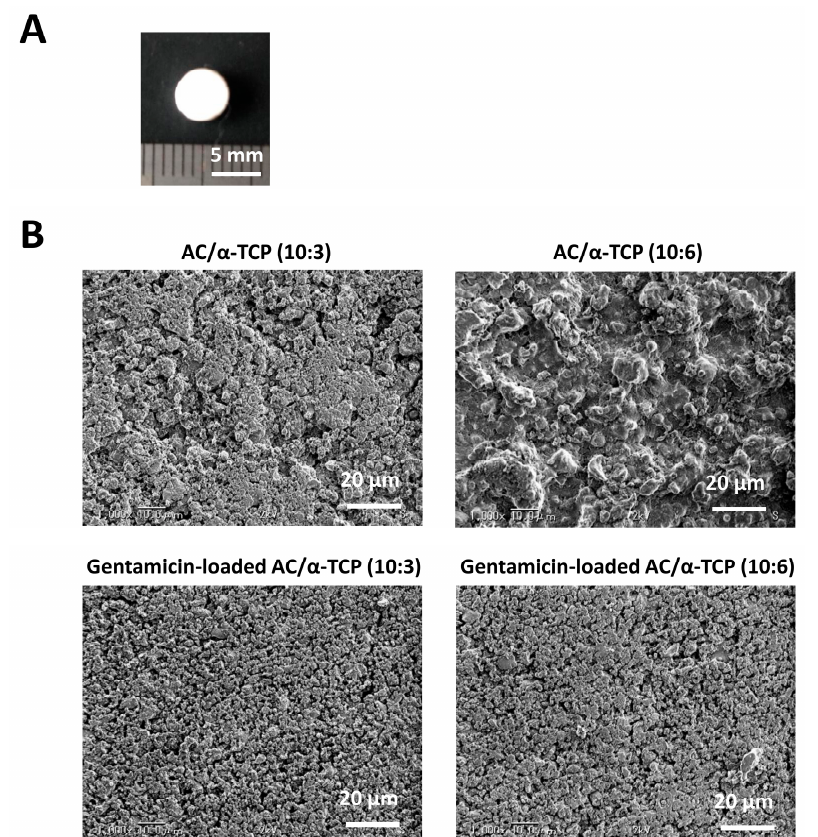
Figure 1. Preparation of gentamicin-loaded AC/ α -TCP composites. ( A ) Photograph of the gentamicin-loaded AC/ α -TCP composite. ( B ) SEM images of the AC/ α -TCP and gentamicin-loaded AC/ α -TCP composites.